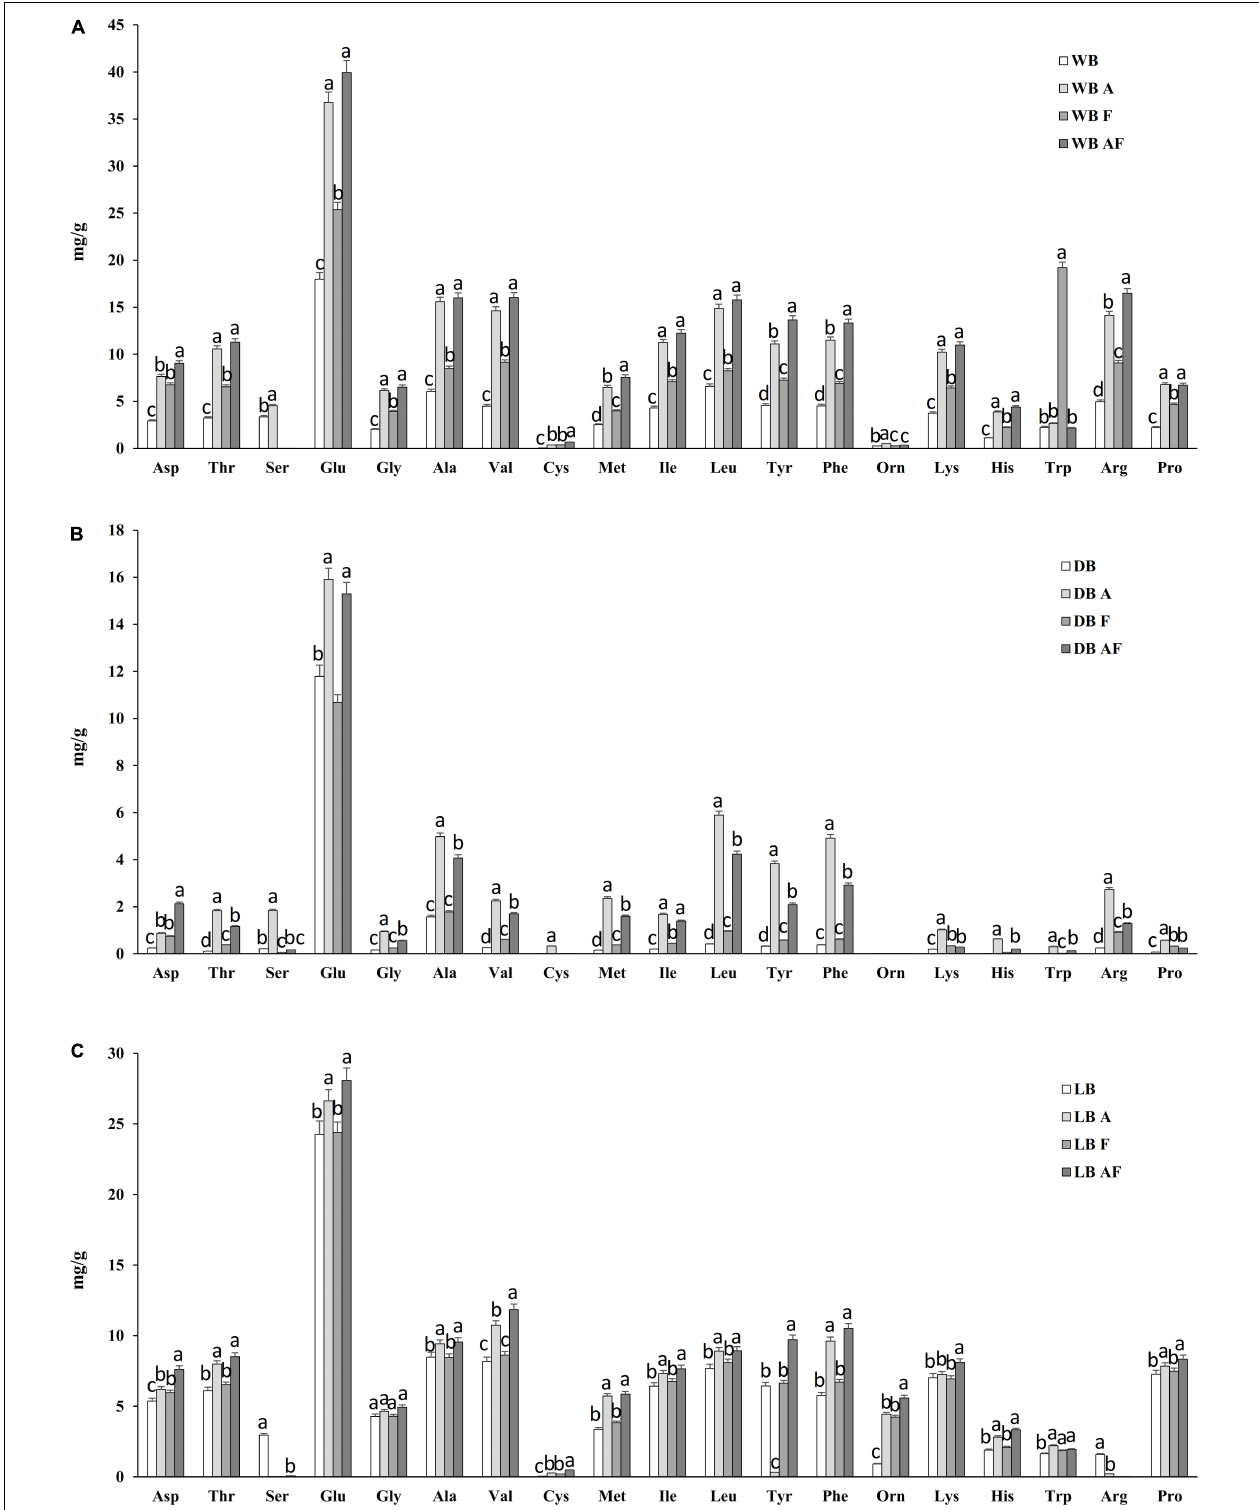
FIGURE 3 | Free amino acids concentration (expressed as milligrams per gram) of wet (WB), dried at low temperature (DB), and lyophilized (LB) Spirulina biomass. All biomasses were also treated with Alcalase R (cid:13) (A, 1% vol/wt), fermented with L. plantarum T0A10 (F, final cell density of circa 7 log10 cfu/g, or fermented and treated with Alcalase R (cid:13) (AF). Enzymatic and microbial treatments were carried out at 30 ◦ C for 24 h. a–c Values with different superscript letters differ significantly ( P < 0.05).